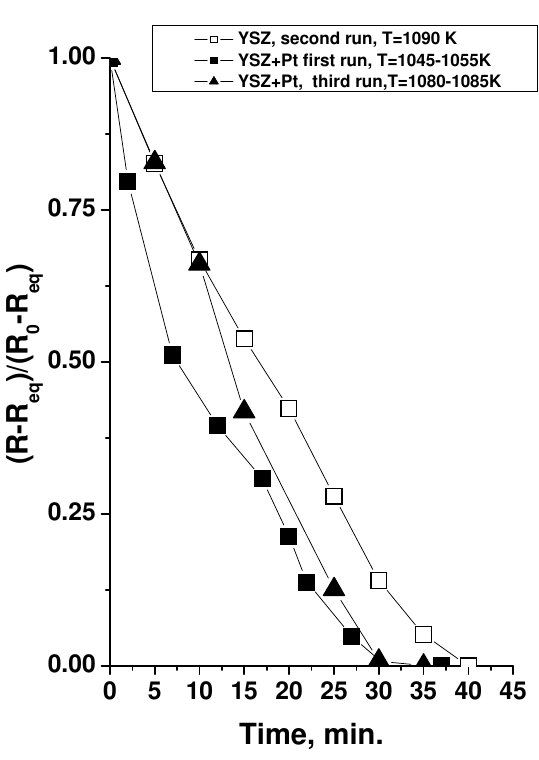
Fig. 7 Normalized kinetic dependence of the resistance of YSZ and Pt-YSZ samples in an oxygen atmosphere. The samples are obtained by spray pyrolysis. R 0 is the initial surface resistance; R eq is the equilibrium resistance at the end of